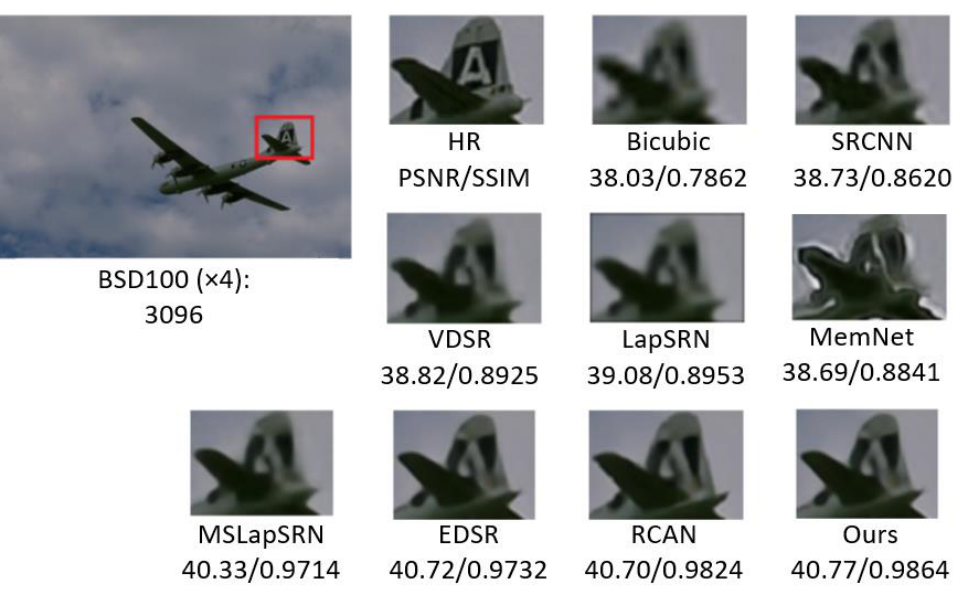
Figure 11. Visual comparison of image “3096” at × 4 scale on the BSD100